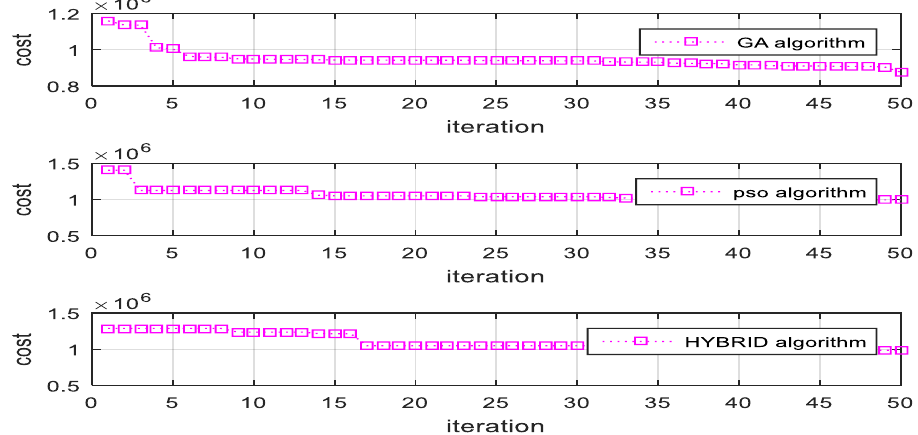
Figure 11. Cost function for GA, PSO, and hybrid-based optimization technique using PEM method for scenario-3.